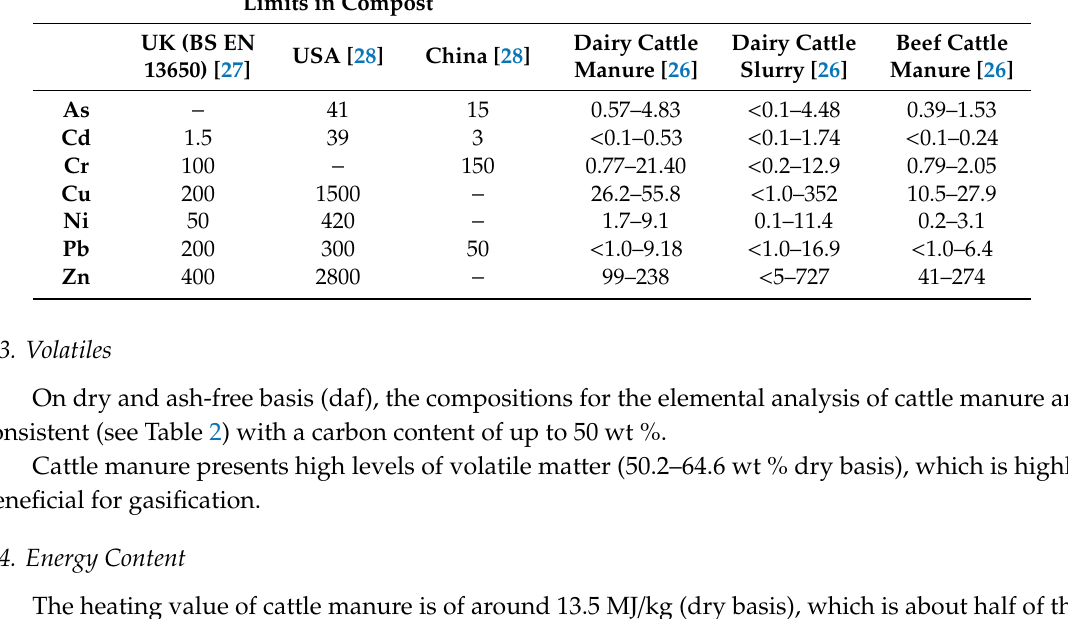
Table 3. Heavy metal contents in manure against standard limits in compost (mg / kg dry matter). Limits in